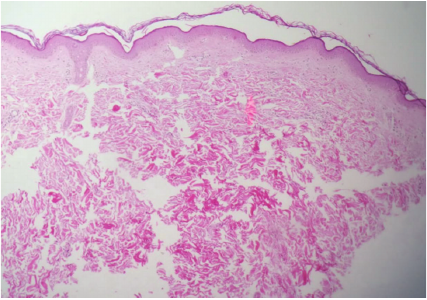
Figure1:Histopathologyview:skinofinnerarmshowsnormalskin structures (H&E stains ∗